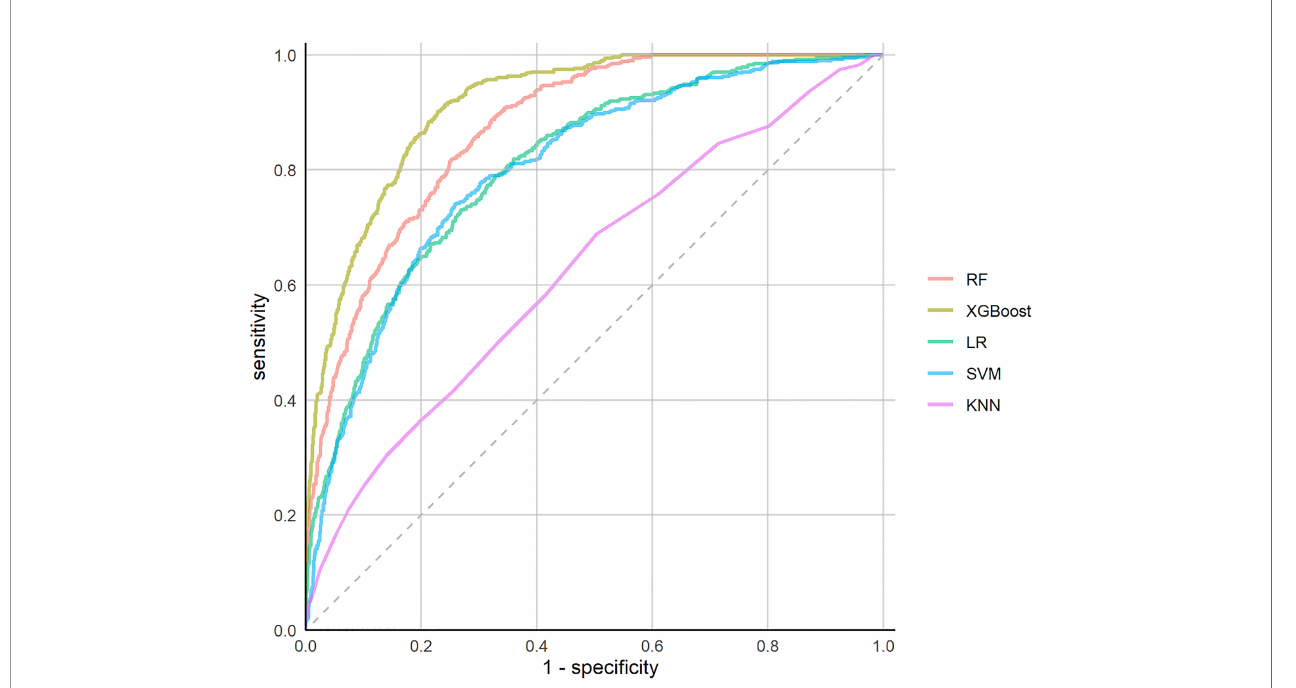
FIGURE 1 | Receiver Operating Characteristics ( ROC ) curves of the ML models.